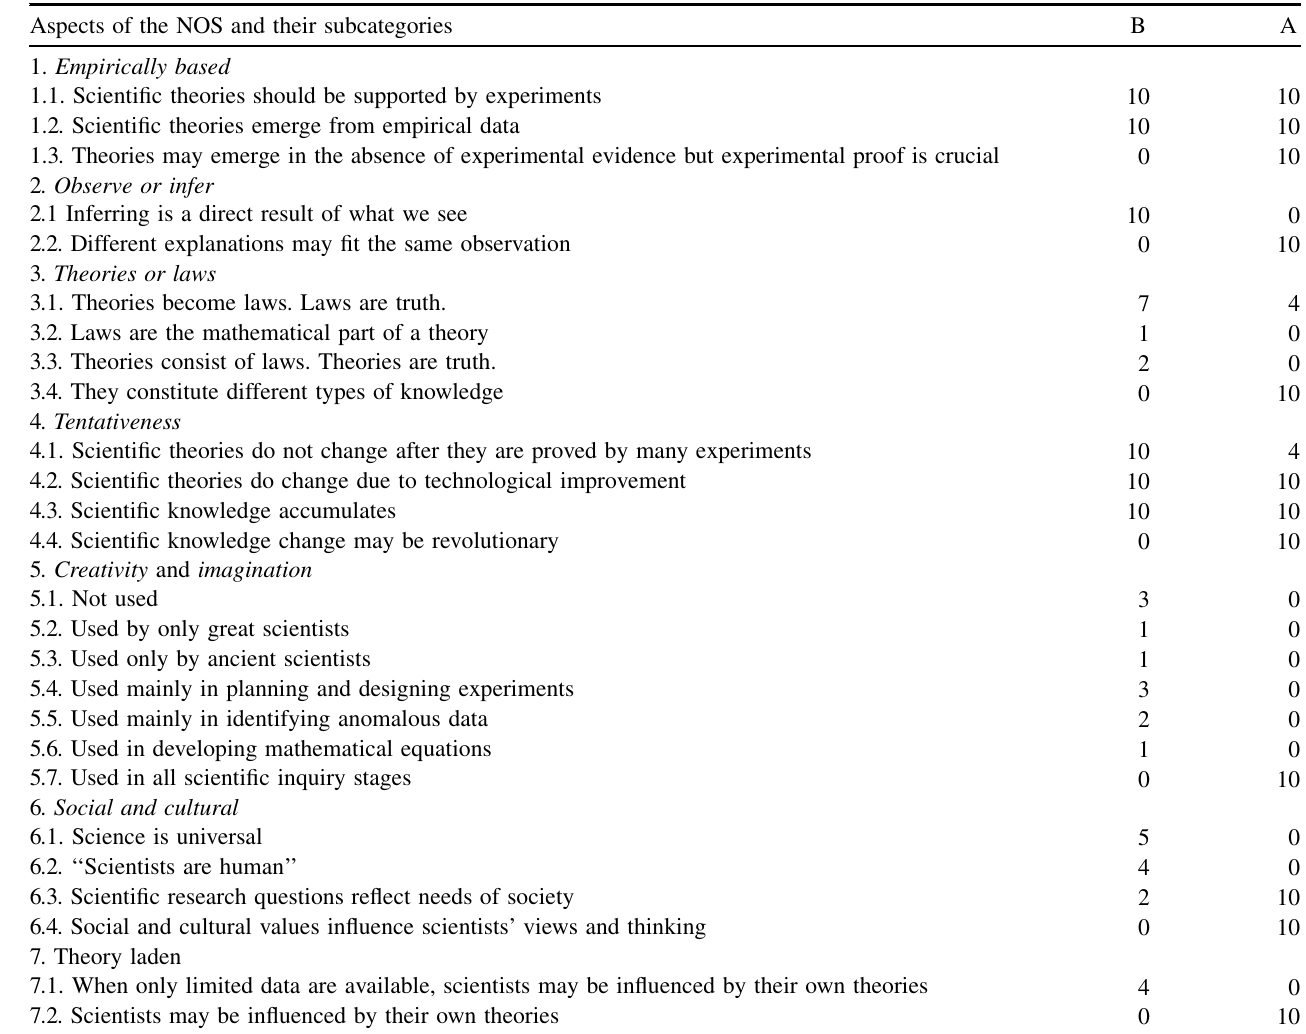
TABLE I. Students’ views of the NOS characteristics, according to the inductive analysis yielded themes, before (B) and after (A) the